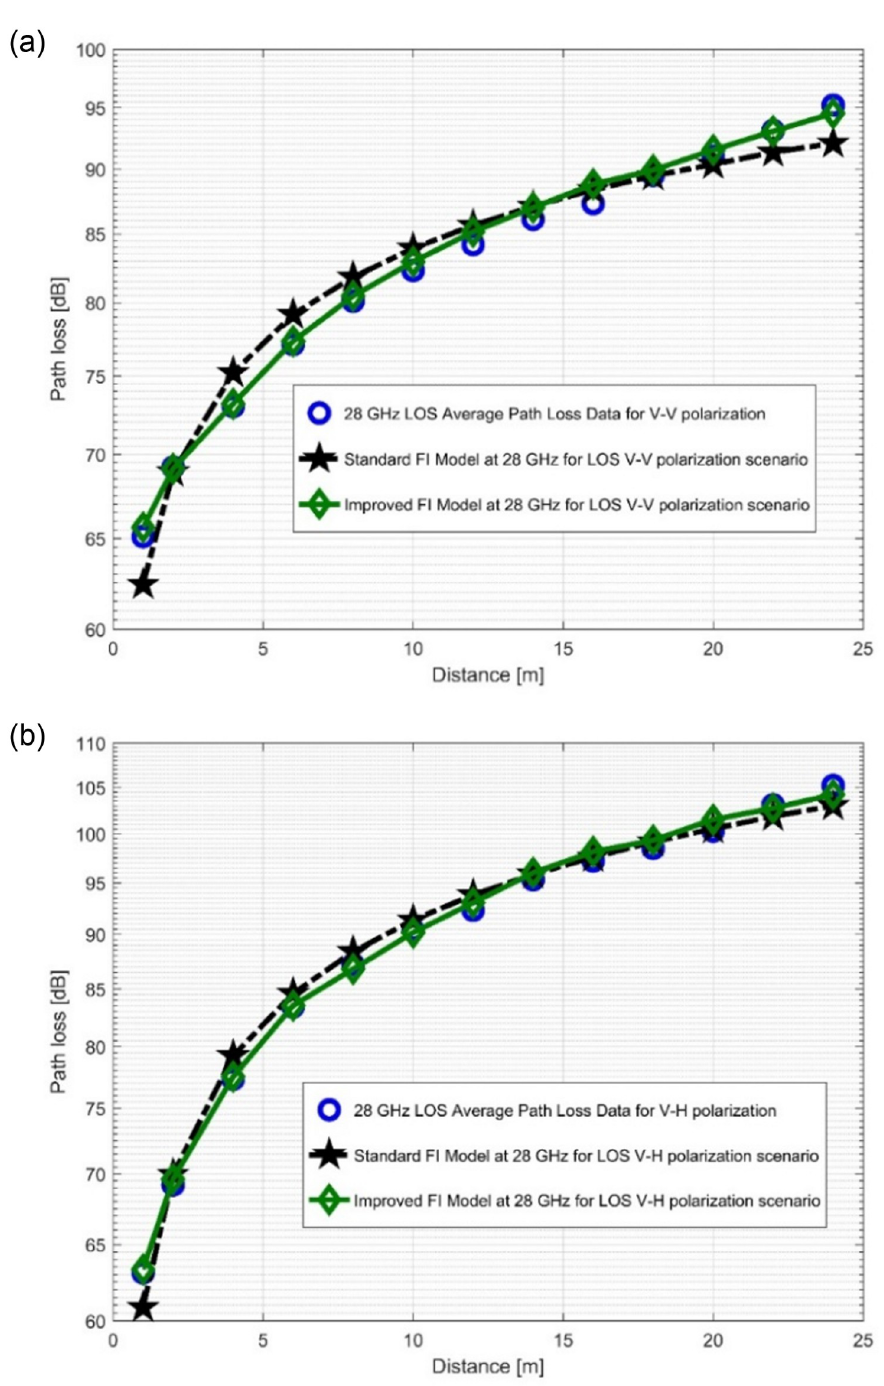
Fig 12. PL vs distance at 28 GHz for the LOS scenario at (a) V-V polarization, (b) V-H polarization. remained stable. For the V-H antenna polarization, there is better performance in the shadow fading standard deviation at 38 GHz, with a performance improvement of 0.5735 dB. The slope of the PL curve is divided into β and β . The model can keep track of the measured PL 1 2 and count all potential WS effects due to these two parameters. Therefore, whenever the value